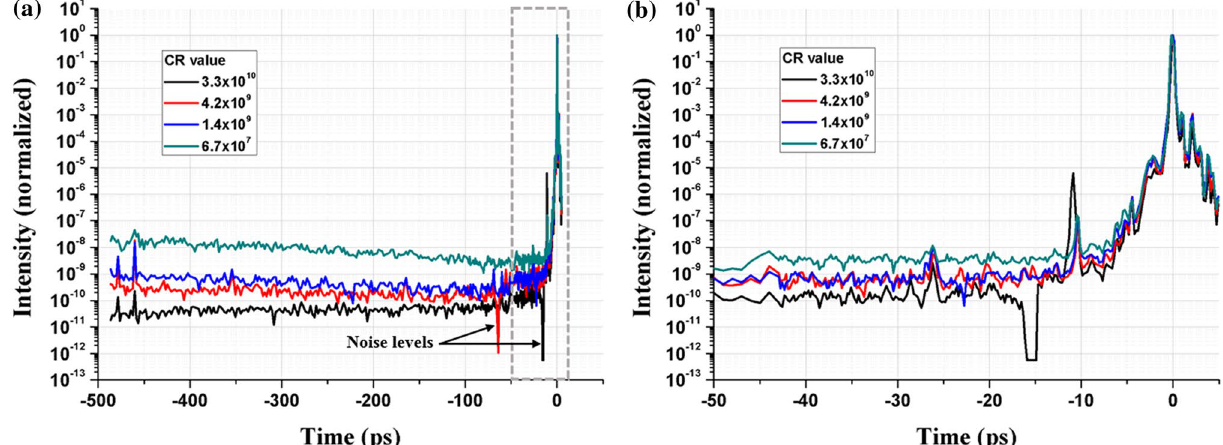
Figure 6. Temporal characterization of the laser pulses interacting with the Mo target. The main pulse corresponds to the time t = 0 ps and the ASE measurement goes up to −480 ps before the main pulse as shown in (a) . The CR is defined by I peak /I ASE . (b) Zoom up to −50 ps before the main pulse, corresponding to the grey dashed rectangular line in (a) .